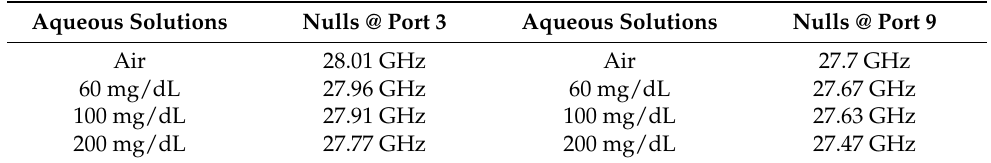
Figure 13. Testing the sensor: ( a ) Placement of the beaker onto the Rotman lens with the cylinder’s geometrical dimensions; ( b ) Characterization of the proposed sensor. Table 2. Shifting null values for ports 3 and 9 measurements based on loading Rotman lens sensor with aqueous solution.